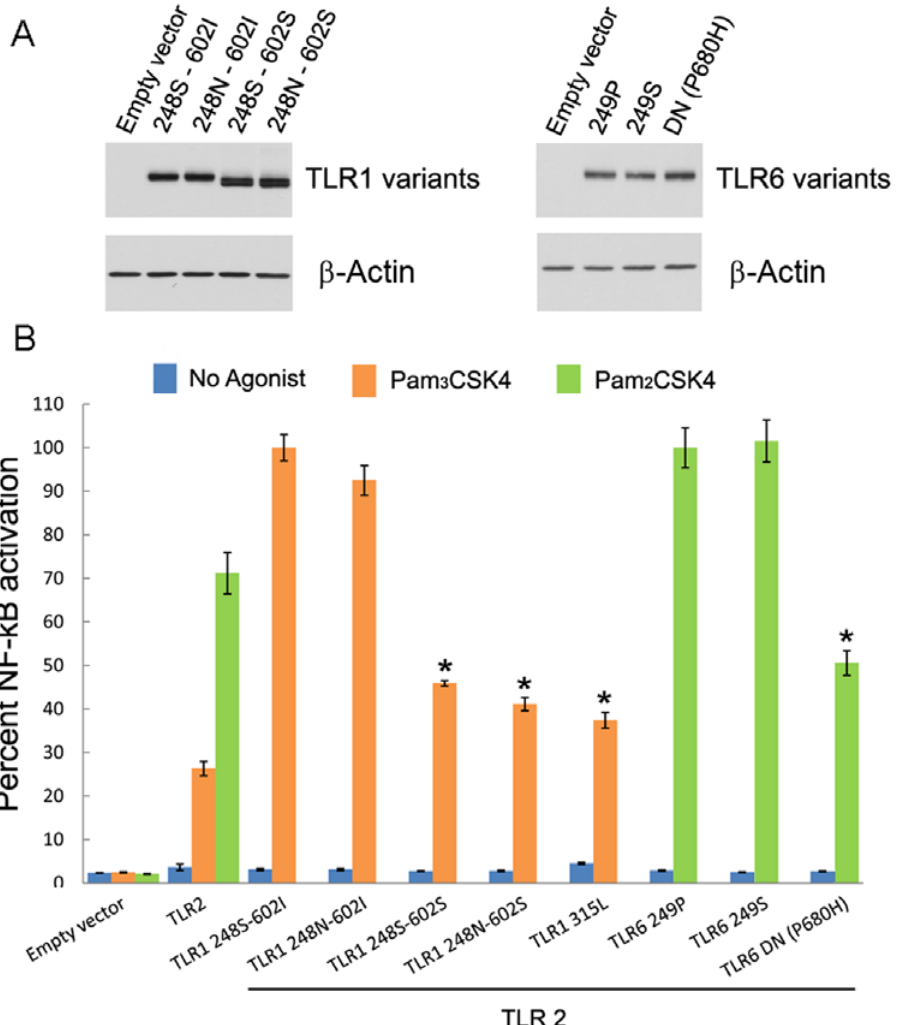
Figure 6. Functional analyses of the positively selected haplotype H34 in Europeans. (A) Level of expression of TLR1 and TLR6 variants. HEK 293T cells were transiently transfected with 100 ng of the indicated construct and whole cell lysates were analyzed by immunoblot with anti-HA tag antibody. (B) The TLR1 602S variant results in a diminished NF-kB signalling. HEK 293T cells were transiently co-transfected with an NF- k B reporter plasmid, a Renilla luciferase plasmid for transfection control and with TLR2 alone or in combination with the indicated TLR1 and TLR6 variants. One day after transfection, cells were stimulated with the indicated agonist at 10 ng/ml for 4 h and luciferase activities were measured. The data shown are the mean 6 SD of three replicates of a representative of three independent experiments, expressed as the percent relative firefly luciferase activity (RLU) (normalized to Renilla luciferase activity). * p , 0.001 (as determined by Student’s t test) when comparing the different TLR1 allelic variants with respect to the ancestral TLR1 248S-602I form, and when comparing the TLR6 variants with the ancestral TLR6 249P